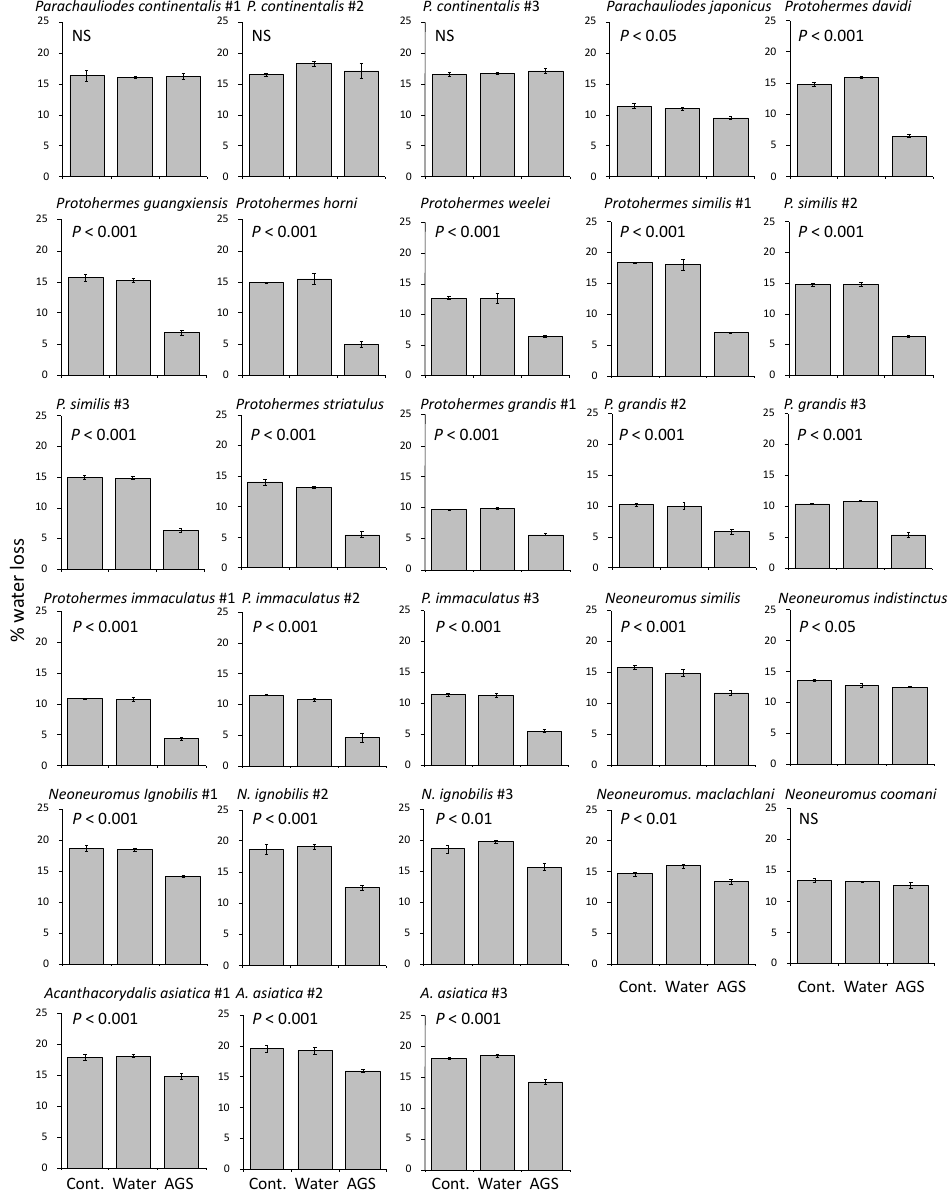
Figure 4. Megaloptera female accessory gland substance effects against dehydration. Mean (± SE, N = 3) water loss (%) estimated using agarose gel kept at 25 °C for 24 h (for explanations of Cont., Water, and AGS, see Figure 1a). This experiment was performed in triplicate (#1–3) in Parachauliodes continentalis , Protohermes similis , P. grandis , P. immaculatus , Neoneuromus ignobilis , and Acanthacorydalis asiatica , while there was no replication for other species. The results of ANOVA are also shown (NS: p > 0.05). The head widths of the large and small ant species used in the feeding experiments were 2.24 mm ( N = 90, SE = 0.06) and 1.16 mm ( N = 79, SE = 0.01), respectively. The addition of the accessory gland substances to 10% sucrose solution decreased the feeding rate of large ants in two of 11 species tested in the experiment (Figure 5 top). In the small ant species, the rate of feeding on the sucrose solution was decreased by adding the accessory gland substances in five of 11 species tested (Figure 5